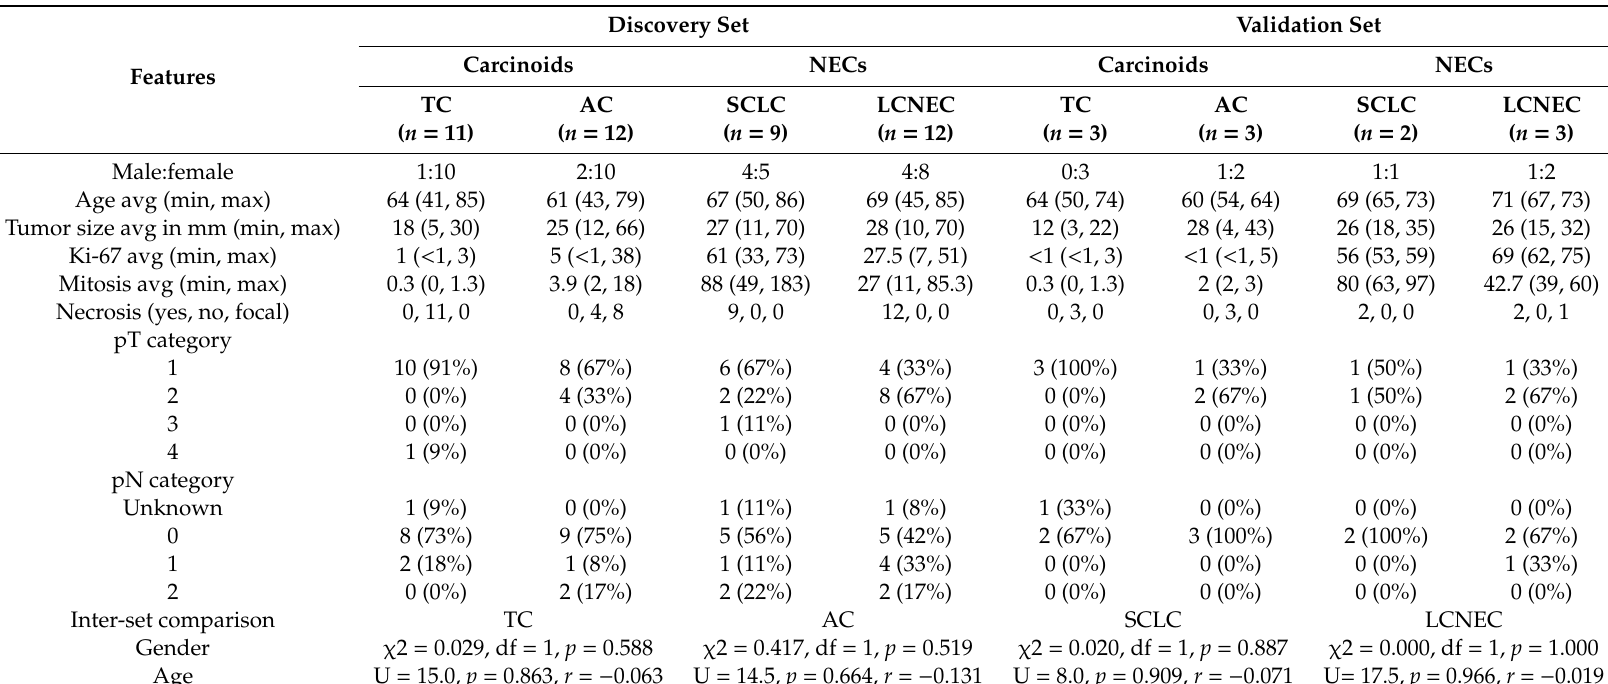
Table 1. Relevant clinical and pathologic data for the four pathological types of lung neuroendocrine neoplasm (NEN) included in discovery and validation sets.